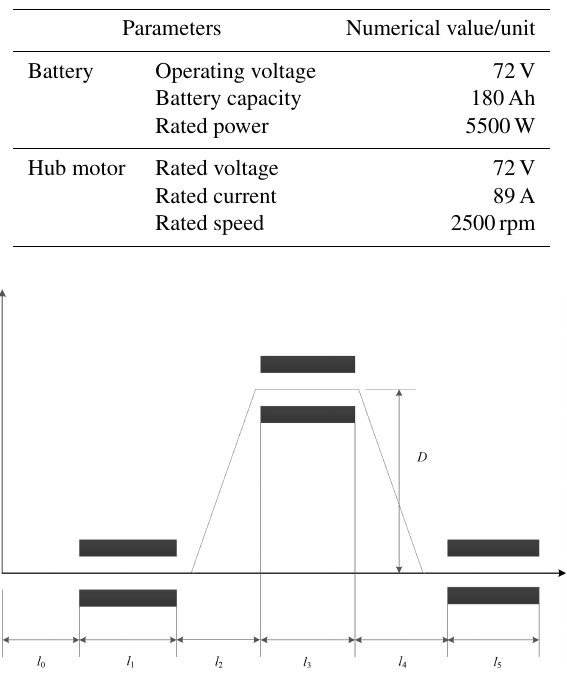
Figure 10. Driving route map.